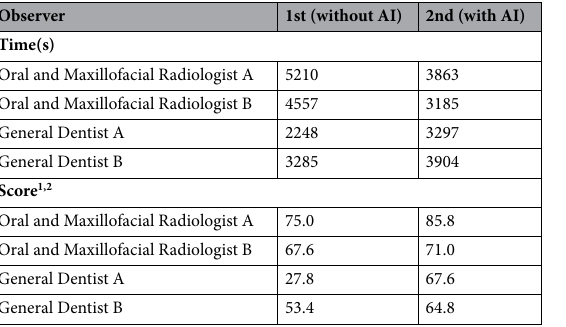
Table 2. Individual outcome of observer study without and with AI. 1 One point for correct answers (both left and right side) and zero point for incorrect answers (either left or right side). 2 Converted from a total of 176 points to 100